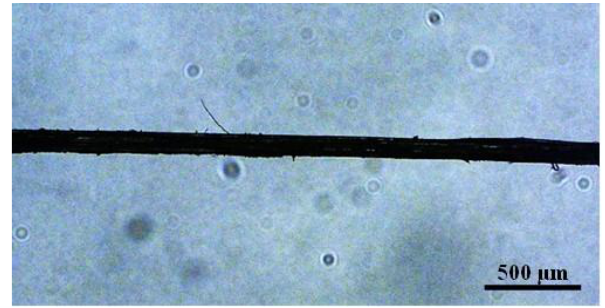
Figure 5. Typical optical microscope image of flax technical fibre.